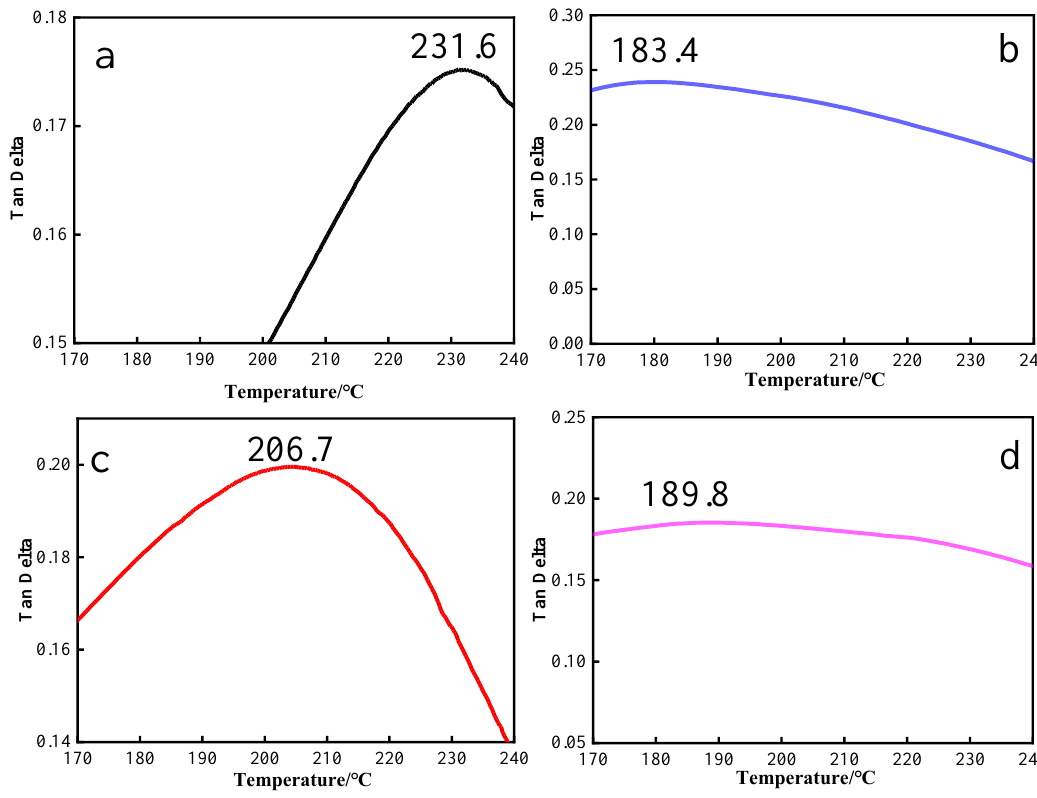
Figure 6. DMA curves of BMI-NH 2 . ( a ) BMI-0, ( b ) BMI-ODA, ( c ) BMI-FDA and ( d ) BMI-MT.